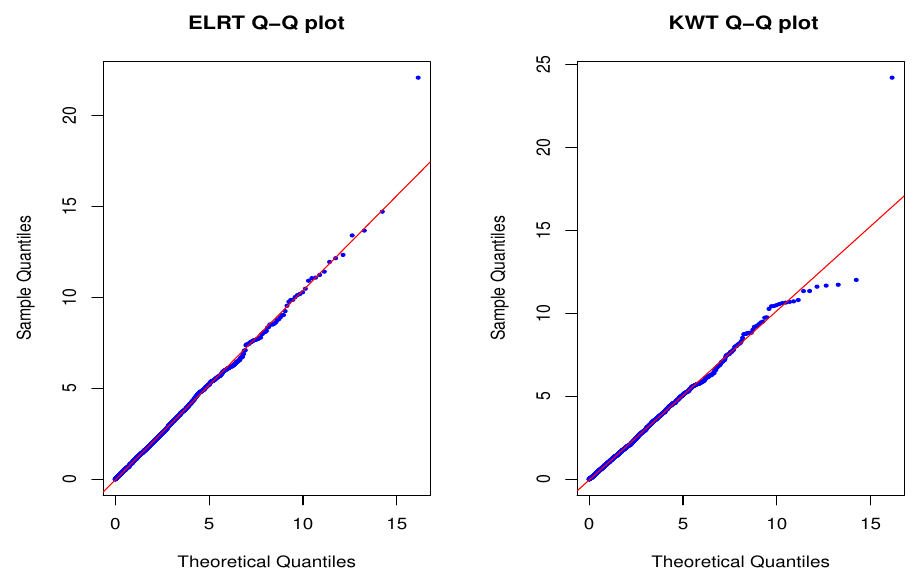
Figure 5. λ 0 = 1, the sample size is (110,110,120), the Q-Q plots of ELRT and KWT for the overall comparison of the 3 Poisson